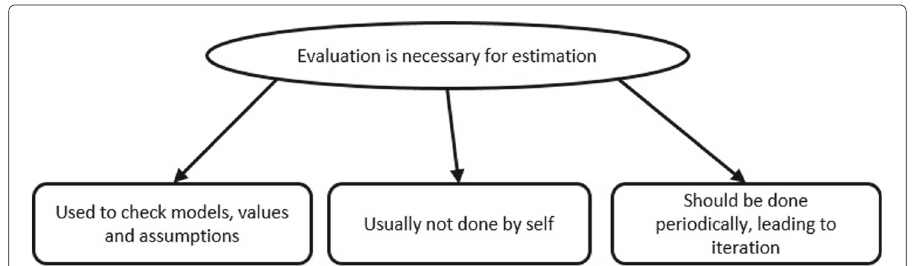
Fig. 8 Analysis map of Theme 2. This figure shows the themes identified within Theme